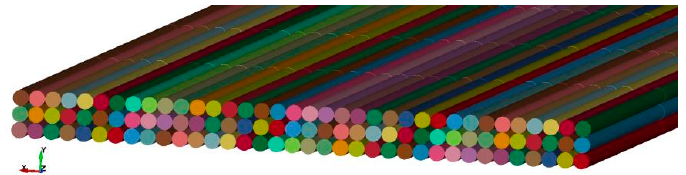
Figure 1. Micro-scale model of a multifilament fiber roving with beam element chains.